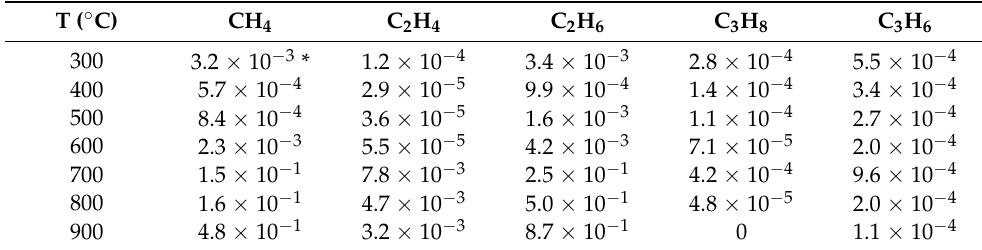
Table 2. Content of gas molecules in the benzene thermal